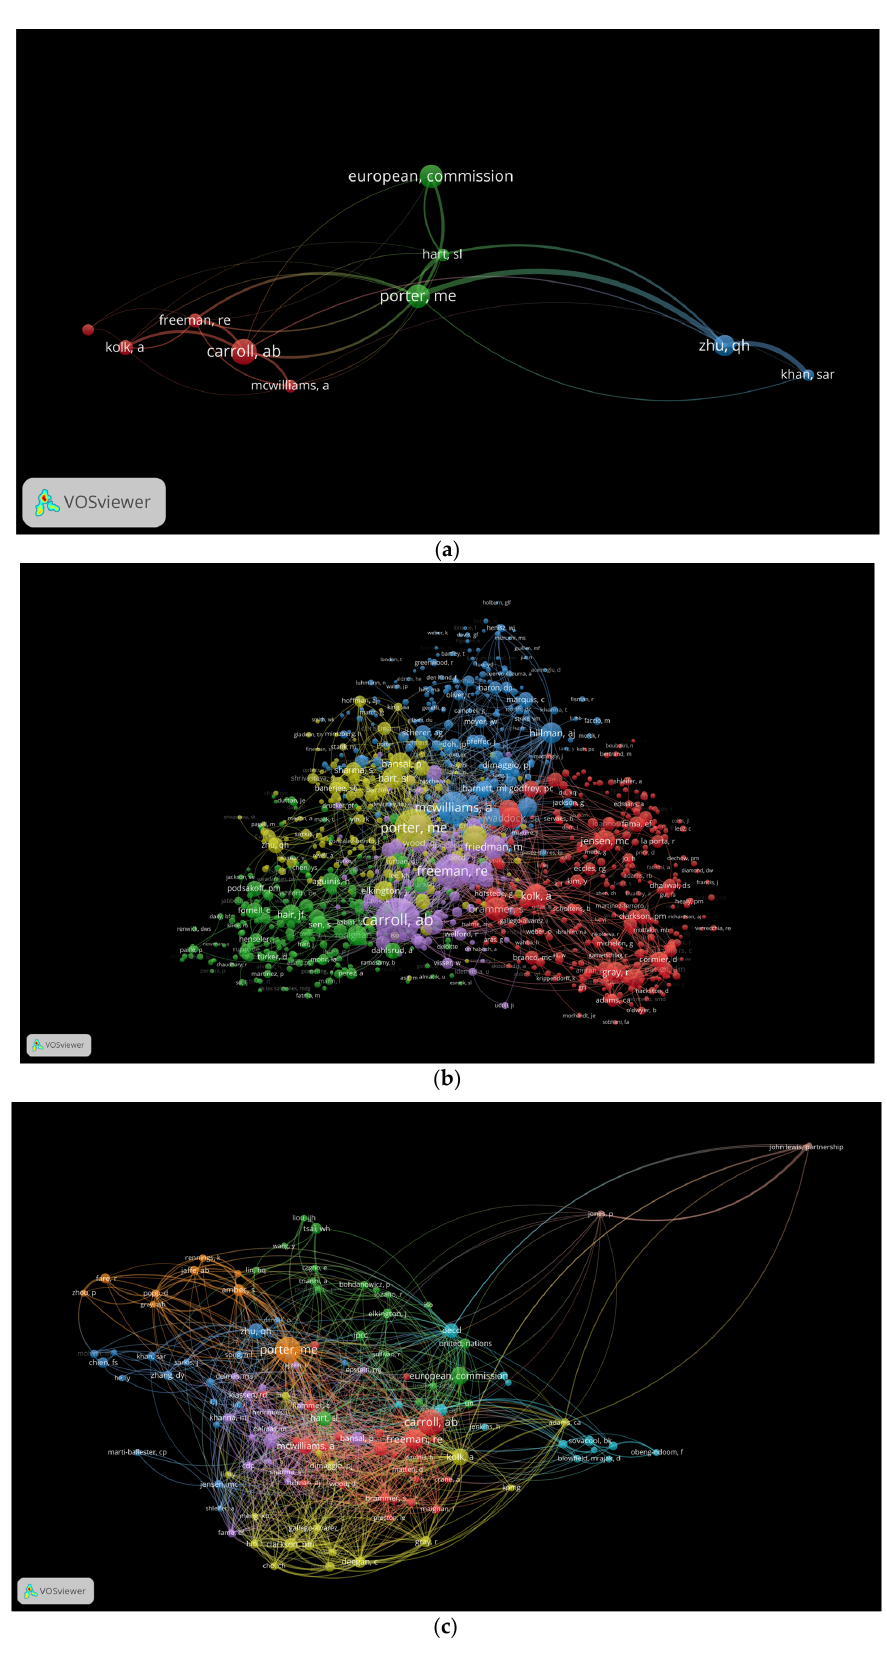
Figure 1. ( a ). Author co-citation network on CSR, environment and energy policy. ( b ). Author co-citation network on CSR and environment.( c ). Author co-citation network on CSR and energy policy.